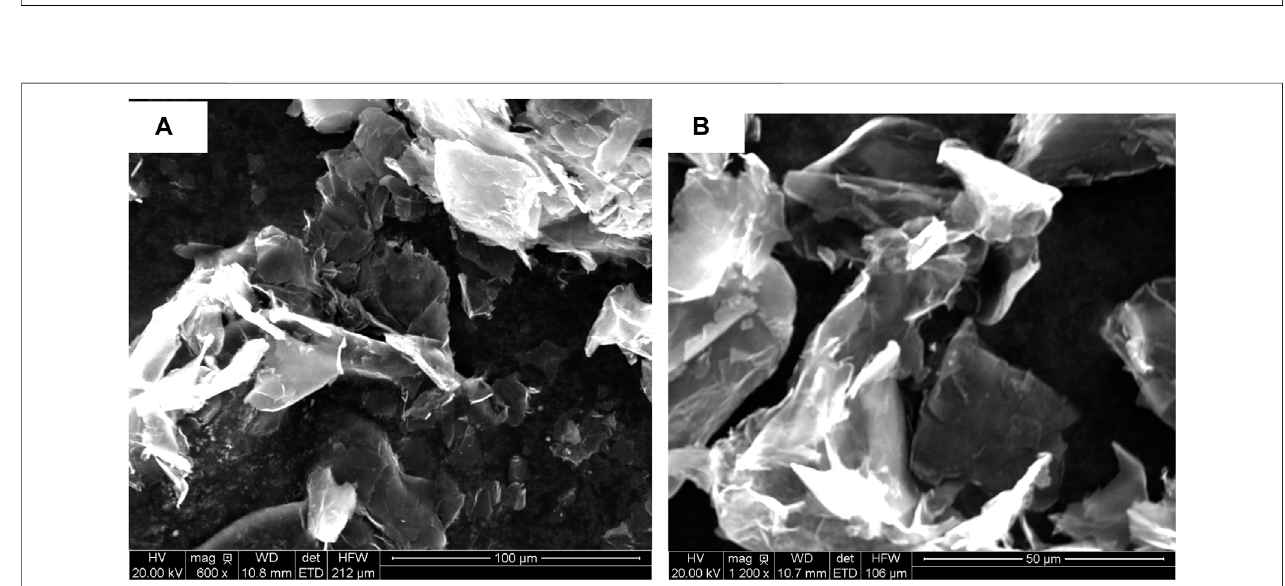
FIGURE 3 | SEM images of rusty carbon steel (A) and rusty carbon steel reacted with 5 wt %PA solution for 24 h (B) .